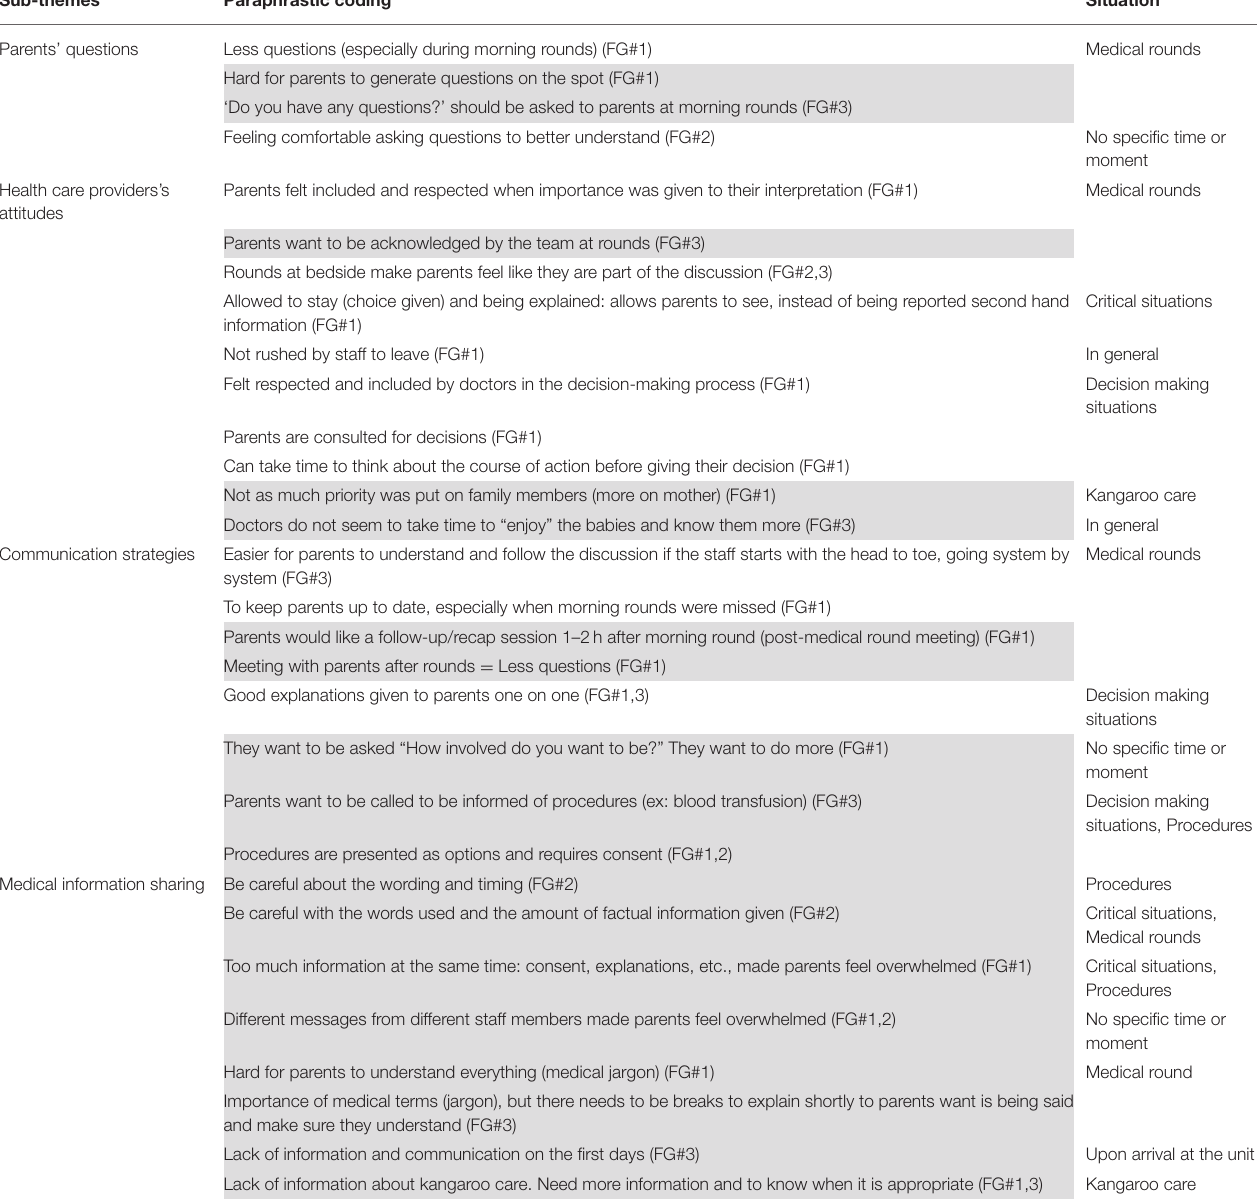
TABLE 2 | Parent-staff interactions. Sub-themes Paraphrastic coding Situation Parents’ questions Medical rounds